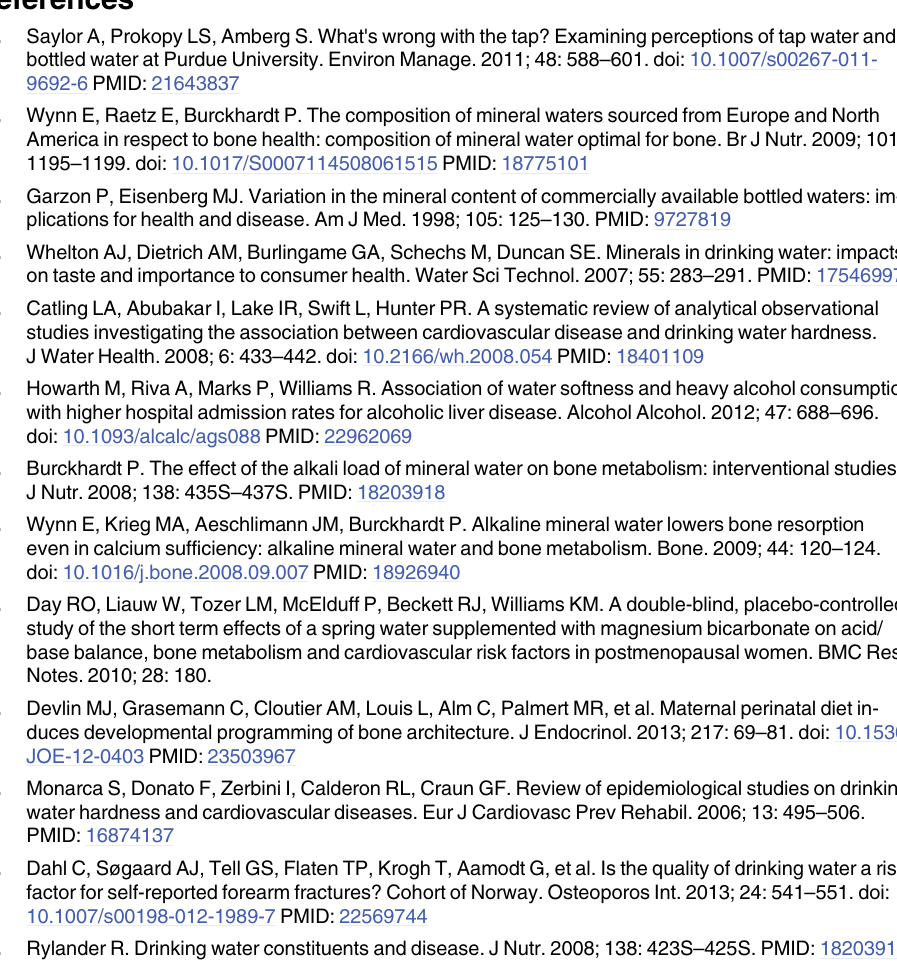
S1 Table. Ion characteristics of the four types of water. All tested parameters in these four water were met the water quality standard (GB/T5750-2006 and GB19298-2003, China). Al- though arsenic, fluoride and nitrate in tap water were higher than that in other three water, the level of them were much lower than standard limit. TW: Tap water, bNW: bottled natural water, bMW: bottled mineralized water, bPW: bottled purified water.